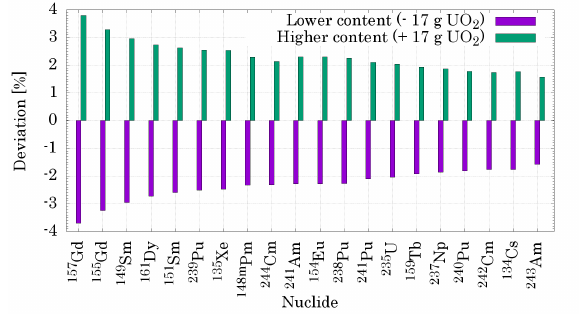
Figure 6. Effect of change in power level on compo- sition.